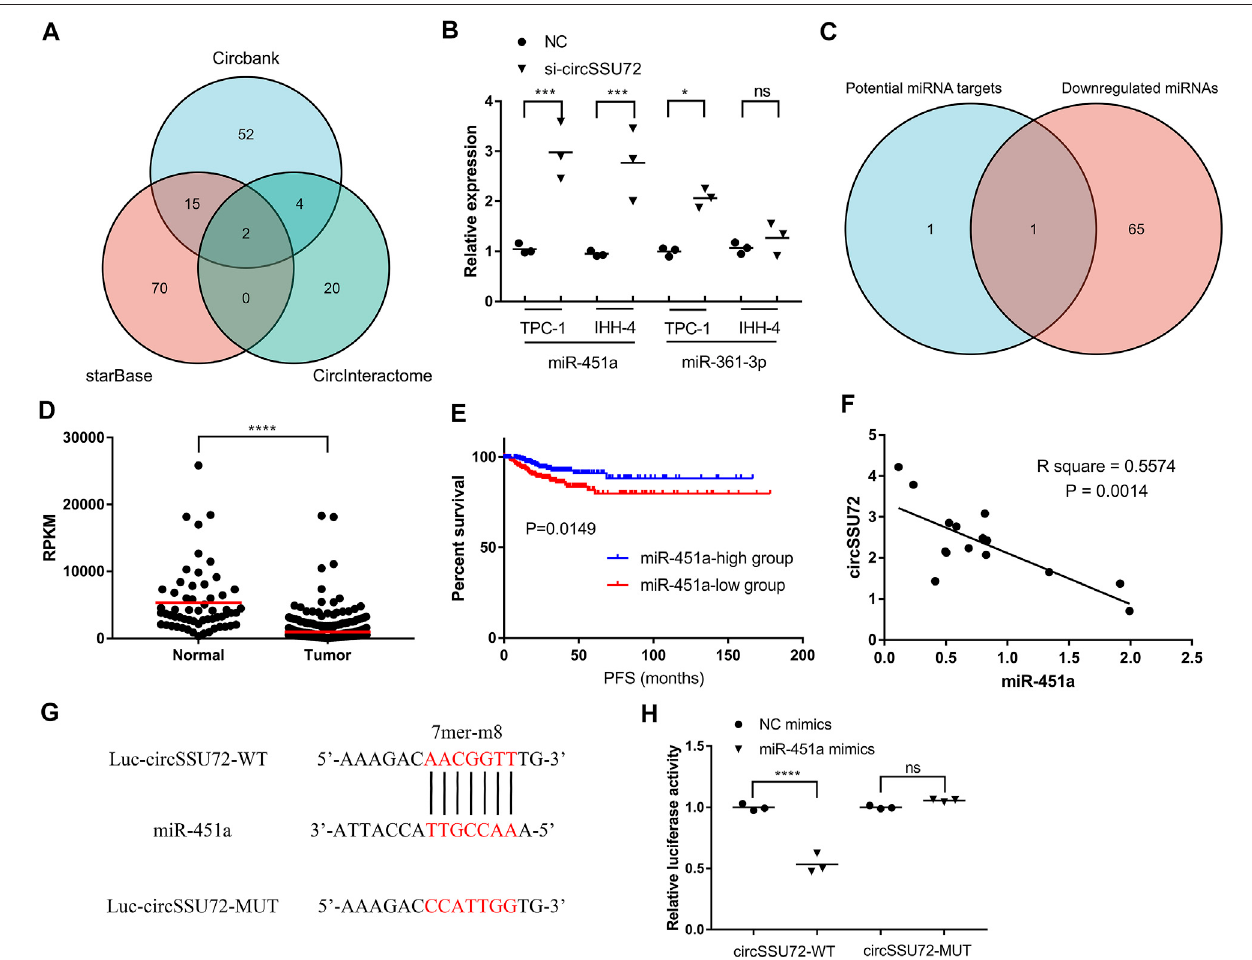
FIGURE 3 | circSSU72 functioned as a sponge for miR-451a. (A) Venn plot of three databases, including Circbank, starBase, and CircInteractome, to predict the targets of circSSU72. (B) The expression of miR-361 – 3p and miR-451a in TPC-1 and IHH-4 cells with or without si-circSSU72 by qRT-PCR ( n = 3). (C) Venn plot of potential target miRNAs and downregulated miRNAs in TCGA-THCA. (D) The expression of miR-451a in TCGA-THCA. (E) The Kaplan-Miere curve of miR-451a concerning the progression-free survival of TCGA-THCA. (F) Correlation between circSSU72 and miR-451a expression in 15 pairs PTC tissues ( n = 15). (G,H) A putativeinteraction sitewithmiR-451aincircSSU72 waspredictedand veri fi edbydual-luciferasereporterassayinTPC-1cell( n =3).* p < 0.05;** p < 0.01;*** p < 0.001; **** p < 0.0001.